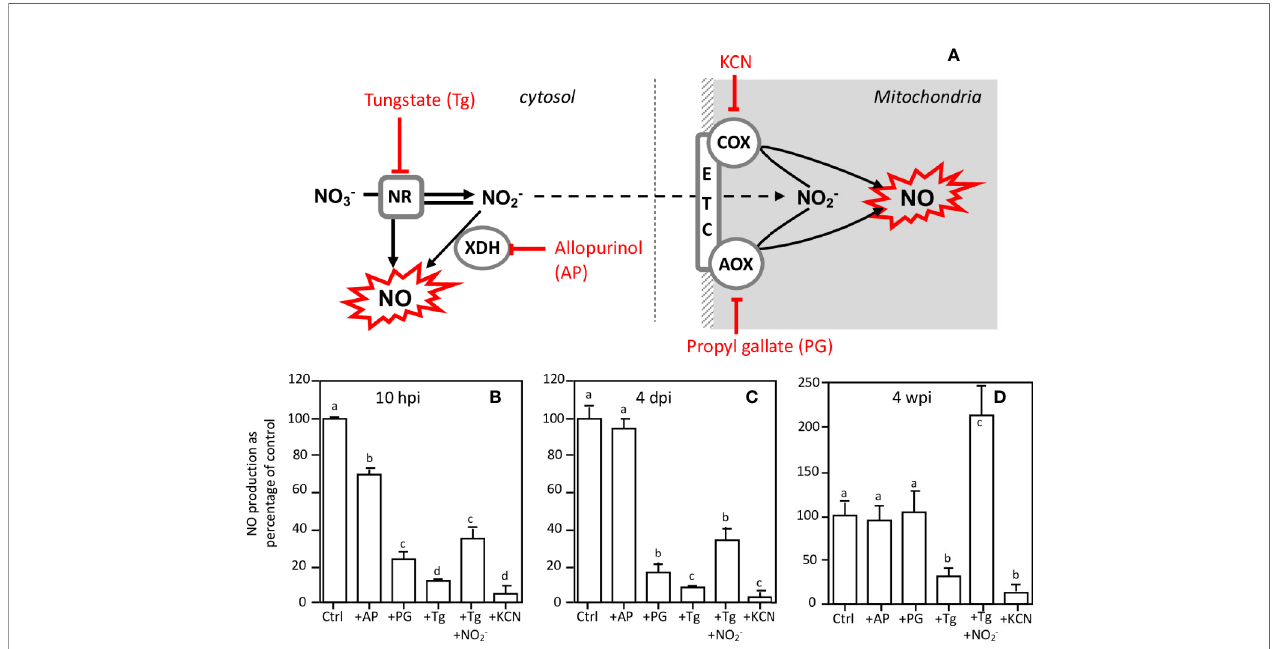
FIGURE 7 | Effects of inhibitors on NO production at various times of the Medicago truncatula symbiosis. (A) , schematic representation of inhibitor targets. NO production of 10 hpi-old (B) and 4 dpi-old (C) roots and of 4 wpi-old nodules (D) was measured after 4 h in the presence of either 1 mM tungstate (Tg), 1 mM allopurinol (AP), 1 mM propyl gallate (PG), 1 mM nitrite (NO 2 − ), or 300 m M KCN. NO production is expressed as the percentage of the control values. Data are means ± SE of three biological replicates. Each measure was realized in three technical replicates. Values followed by different letters are signi fi cantly different according to one-way ANOVA analysis followed by a Fisher test (P < 0.05). dpi, day post inoculation; hpi, hour post inoculation; wpi, week post inoculation. AOX, alternative oxidase; COX, cytochrome oxidase; ETC, electron transfer chain; NR, nitrate reductase; XDH, xanthine dehydrogenase.